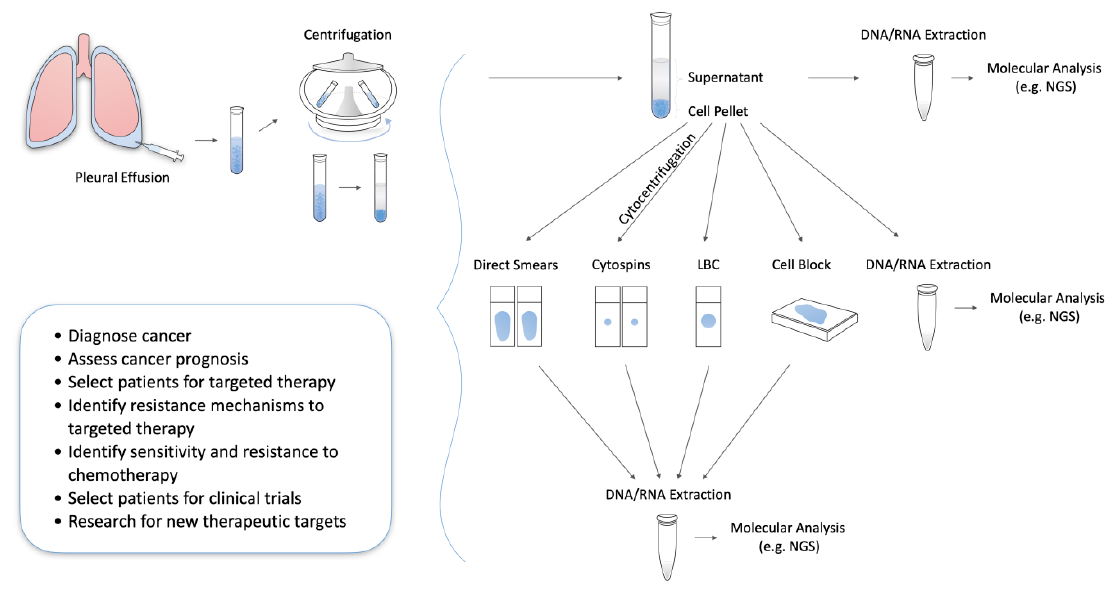
Figure 1. Pleural fluid processing to facilitate diagnosis, prognosis, and guide therapy of metastatic cancers. NGS = Next generation sequencing, LBC = Liquid-based cytology.